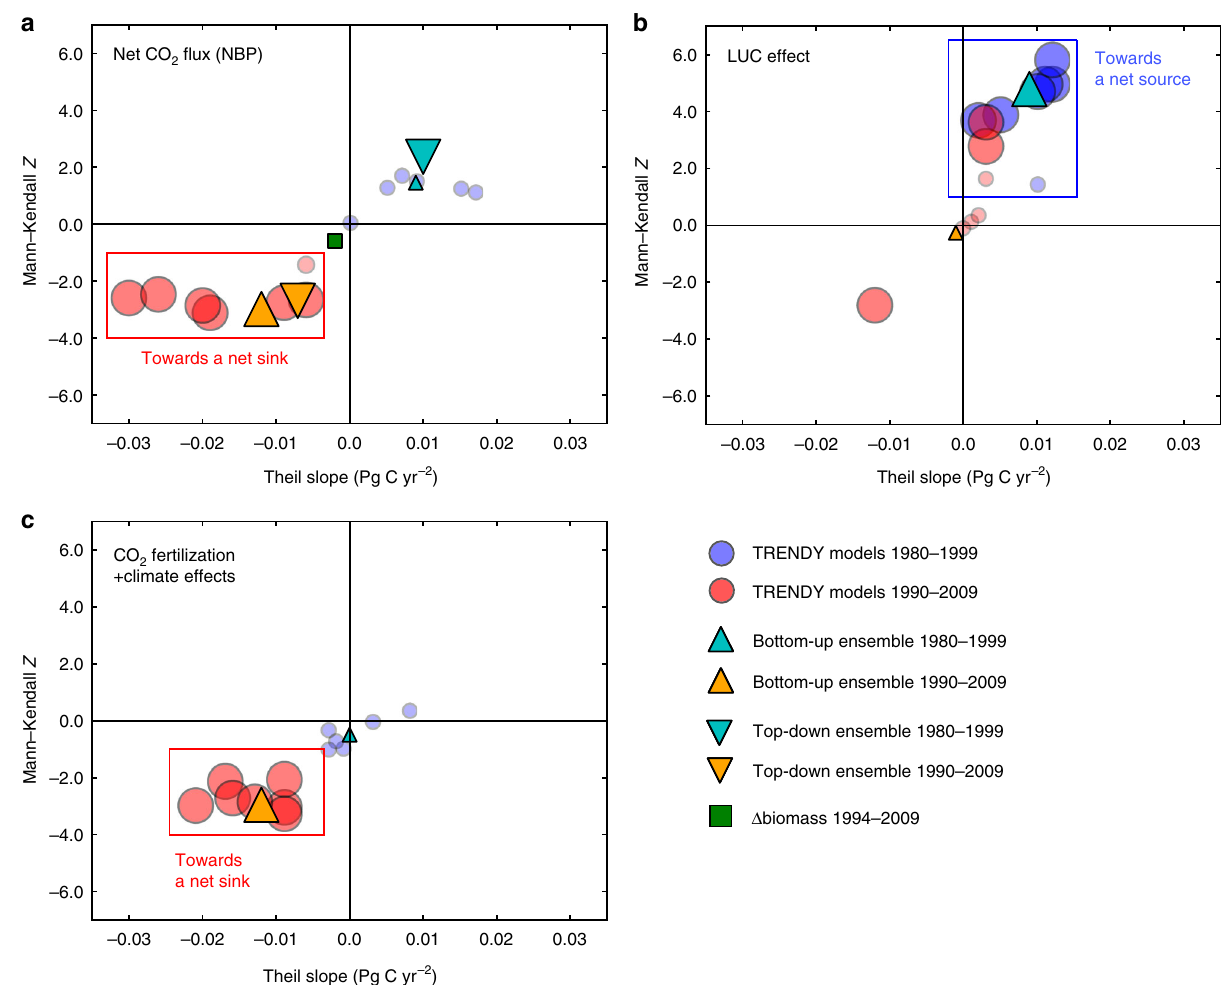
Fig. 2 Trends in net CO 2 fl ux and its components for the past 30 years. Results of two trend tests (Mann – Kendall and Theil slope tests) on a , net CO 2 fl ux (NBP) from the TRENDY S3 (seven models: blue circles for 1980 – 1999 and red circles for 1990 – 2009, and ensemble average: a cyan upper triangle for 1980 – 1999 and an orange upper triangle for 1990 – 2009) are shown along with those on the atmospheric CO 2 inversions (ensemble average: a cyan lower triangle for 1980 − 1999 and an orange lower triangle for 1990 – 2009) and Δ biomass (a green square for 1994 − 2009). The trend tests on attributing factors to NBP are illustrated for b , the LUC effect and c , CO 2 fertilization + climate effects. Size of markers indicates statistical signi fi cance of trends: larger ( p < 0.05) and smaller ( p ≥